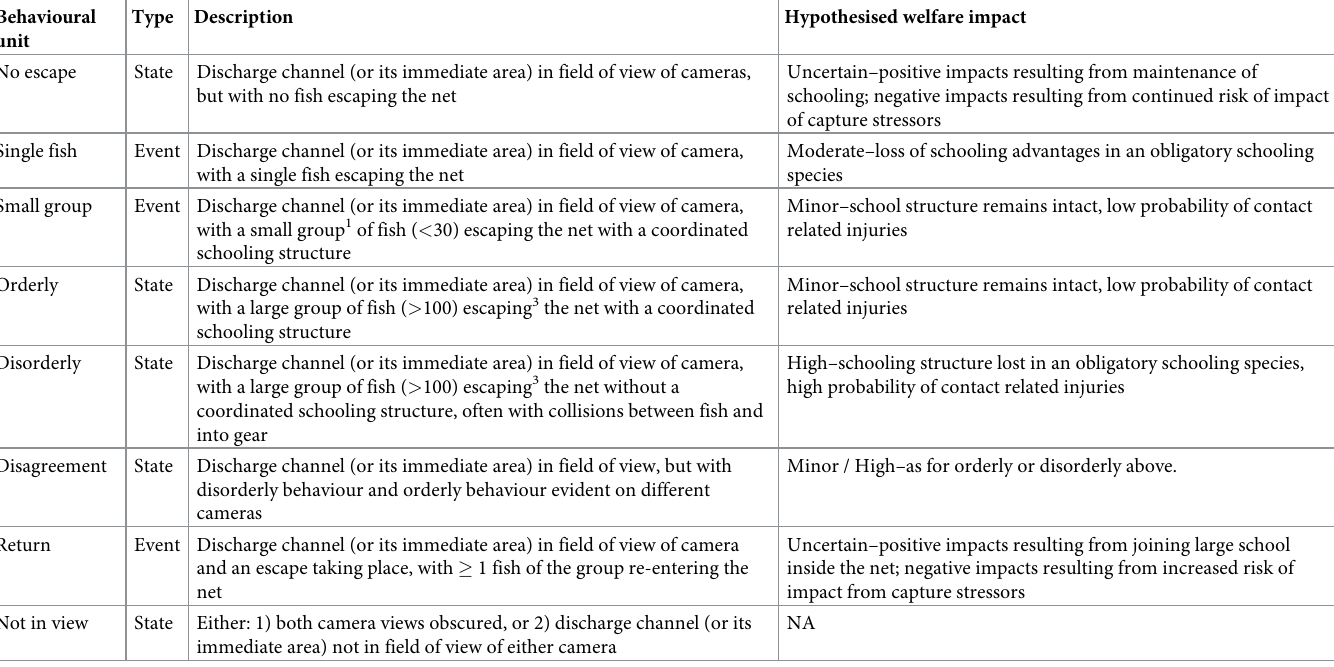
Table 1. Slipping behaviour ethogram. Ethogram of collective fish behaviour during escape from purse seines. Behavioural